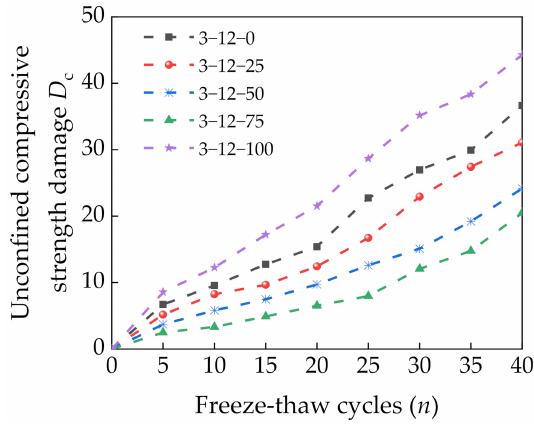
Figure 10. Relationship between freeze–thaw cycles and the unconfined compressive strength damage D c